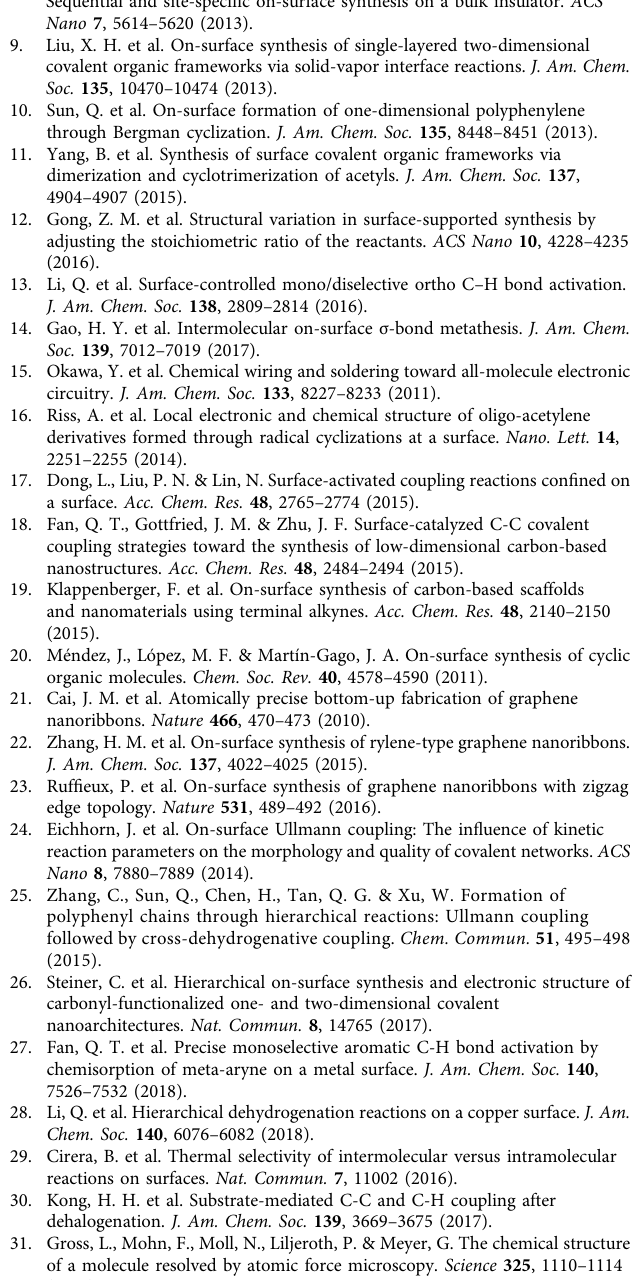
Table 1 Statistical analysis of self-assembled DATP/TPCA clusters Total # of counted molecules DATP = 944 (TPCA = 875)